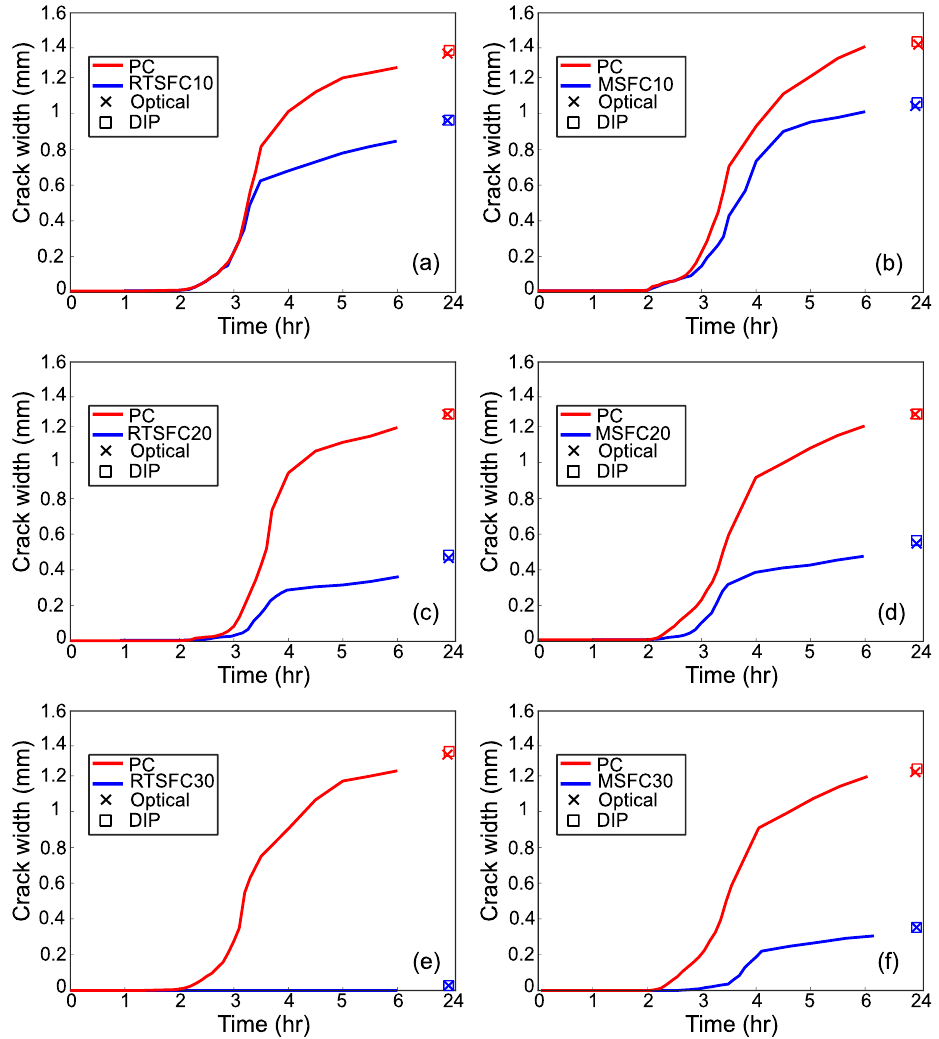
Figure 17. Crack width evolution for all specimens compared to their PC counterpart: ( a ) RTSFC10; ( b ) MSFC10; ( c ) RTSFC20; ( d ) MSFC20; ( e ) RTSFC20; ( f ) MSFC30.